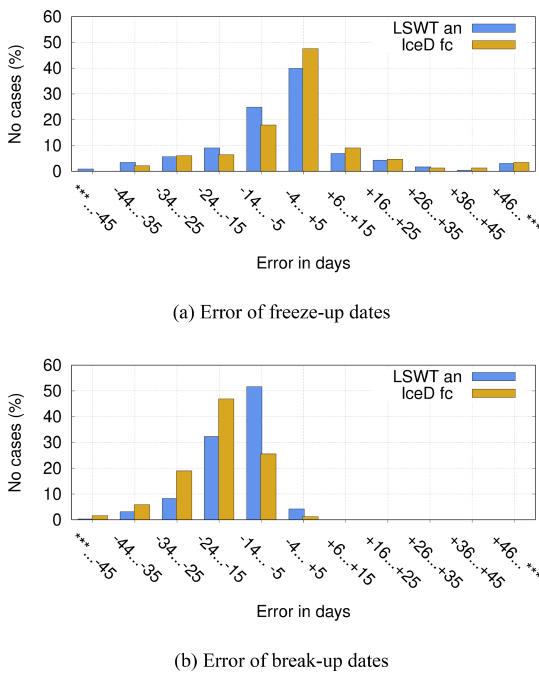
Figure 5. Frequency distribution of the difference between anal- ysed/forecast and observed freeze-up and break-up dates over all lakes, 2012–2018. Variables used in diagnosis of ice existence: anal- ysed LSWT crossing the freezing point (blue) and forecast ice thick- ness > 1mm (yellow). Observed variable: freeze-up date by SYKE; x axis: difference (fc-ob), unit is day; y axis: percentage of all cases.